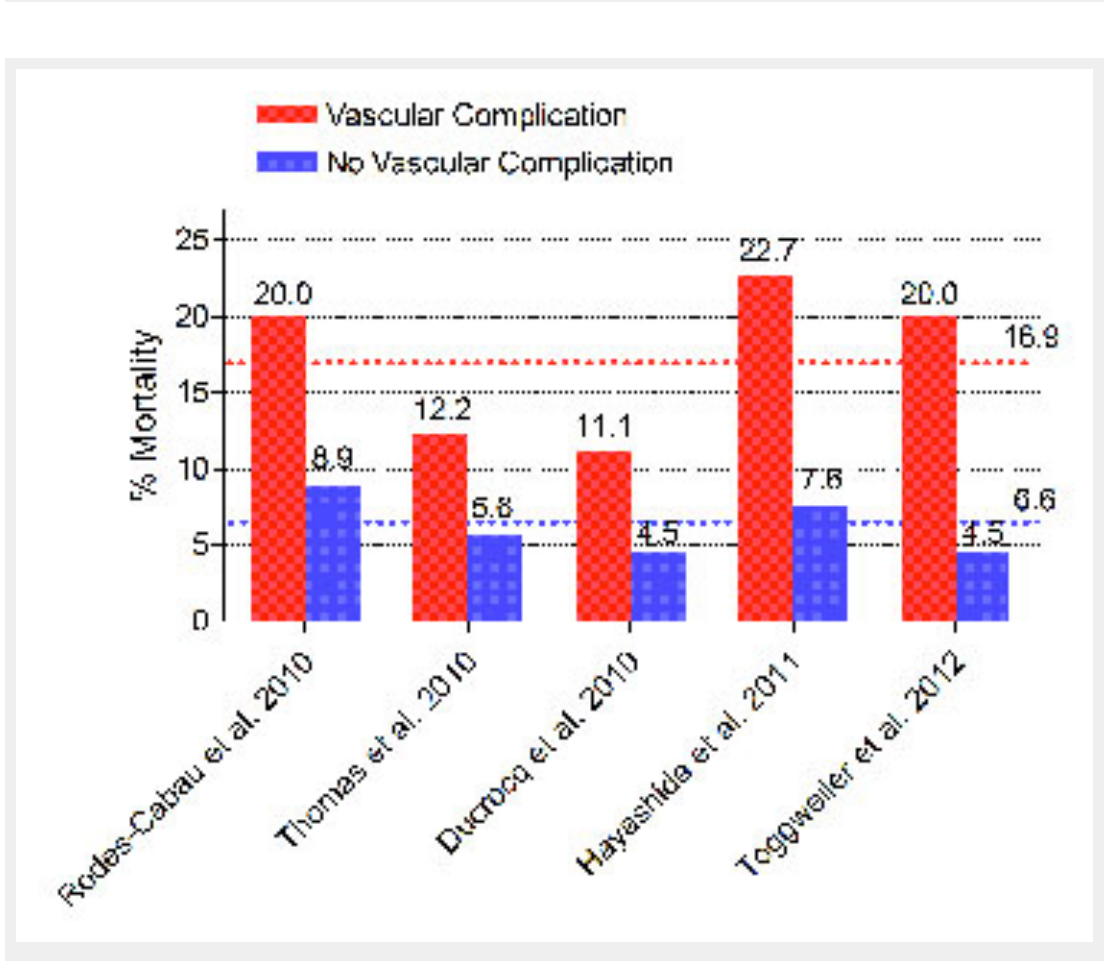
Figure 5 Impact of vascular complications on 30-day mortality. 30-day mortality in patients with a (major) vascular complication was consistently higher than in those without. In pooled analysis of all 5 studies including >1000 patients, mortality was 16.9% (red dotted line) and 6.6% (blue dotted line) in patients with and without vascular